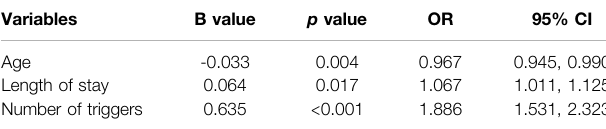
TABLE 4 | Logistic regression for SAEs.